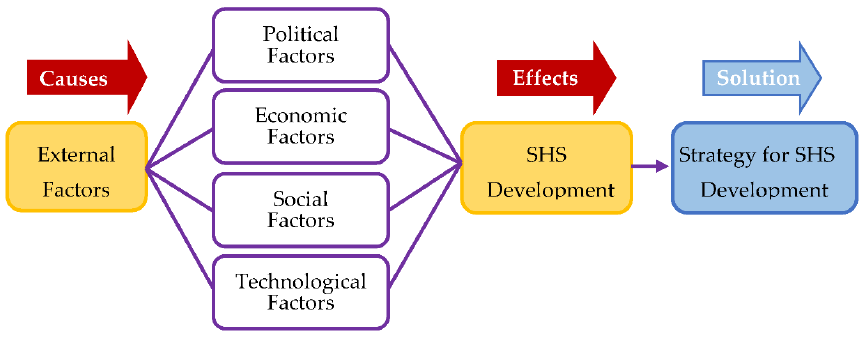
Figure 3. Framework to analyze the development strategy for sustainable SHS.